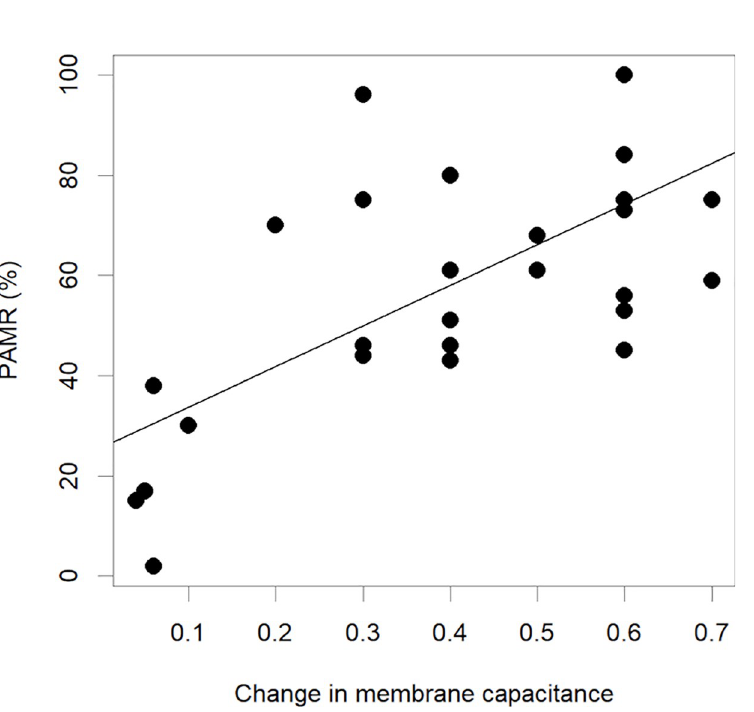
Fig 6. The relationship between the proportionate change in membrane capacitance and percentage available milk removed (PAMR) from the breast for all subjects.